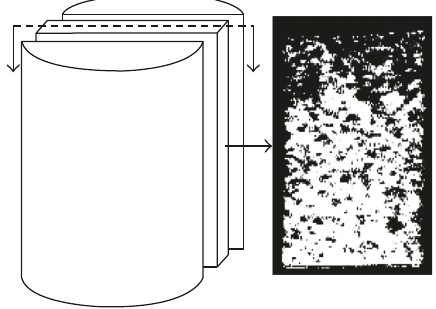
Figure 10: Typical cutting plane.